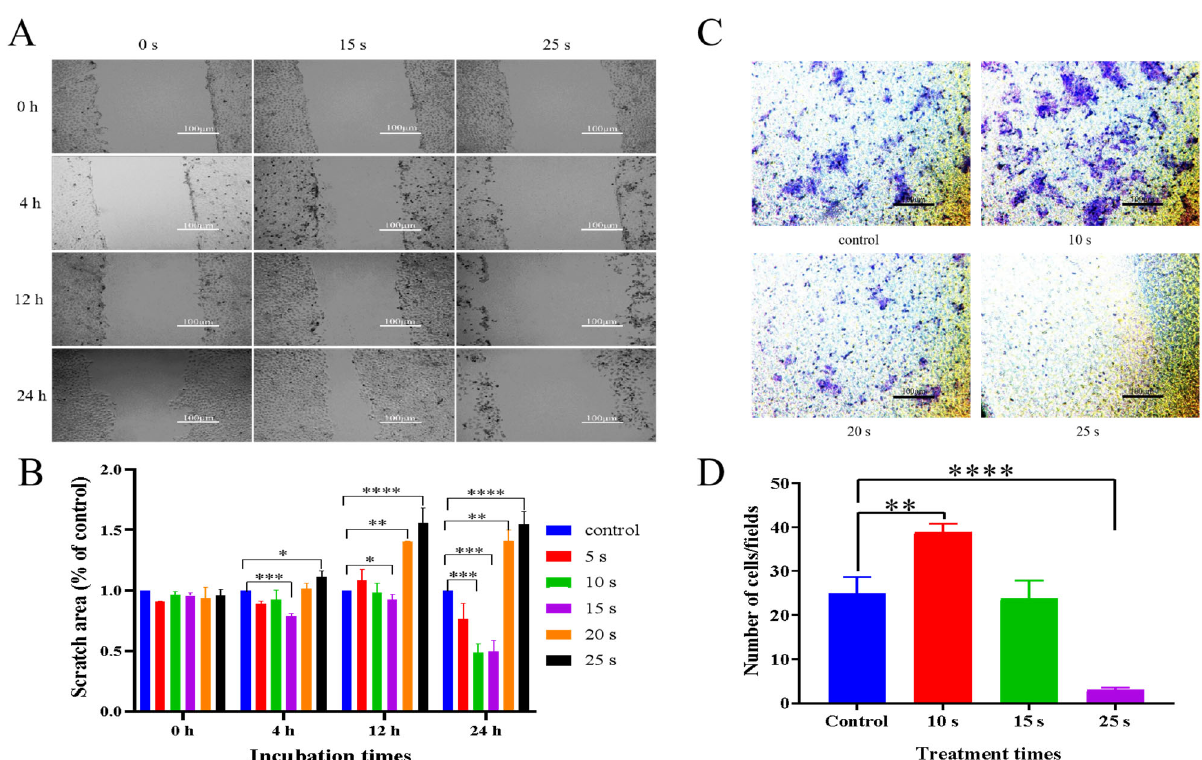
Figure 5. Effect of NTP treatment on HaCaT cell migration. ( A ) Migration of HaCaT cells treated with NTP by the scratch wound healing assay. ( B ) Quantitative analysis was performed by measuring the scratch area of HaCaT cells using Image J software. ( C ) Migration of HaCaT cells treated with NTP by the transwell assay, the picture scale size was the same as A . ( D ) Quantitative analysis was performed by measuring the number of HaCaT cells crossing the membrane using Image J software. Data represent the mean ± SD of three independent experiments. * p < 0.05, ** p < 0.001, *** p < 0.001, **** p < 0.0001 with ANOVA compared with the control.